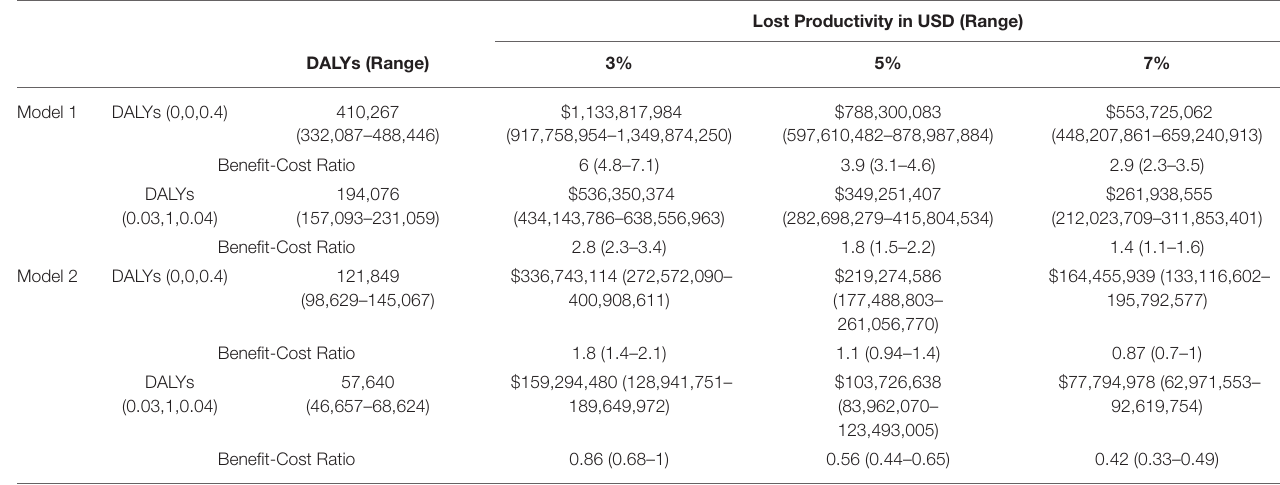
Lost Productivity in USD (Range)